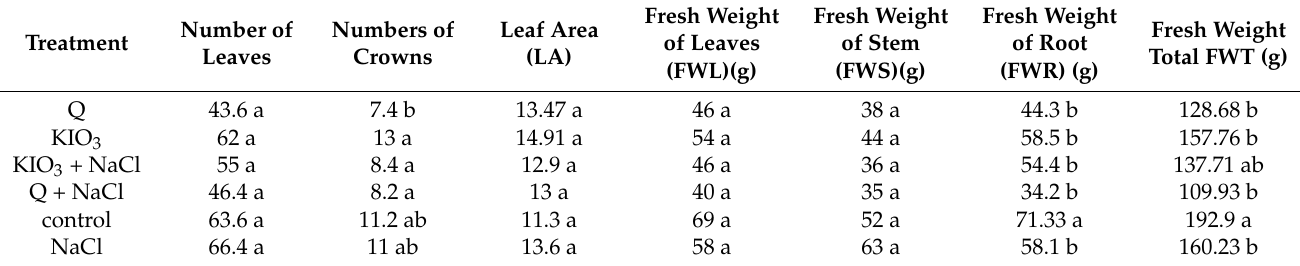
Figure 2. Total dry biomass of the strawberry plants treated with iodine-based products, represented in grams, in the three samplings under normal and salt stress conditions. Values with same letters do not show statistically significant differences, p ≥ 0.05. Table 3. Growth parameters in strawberry plant in third